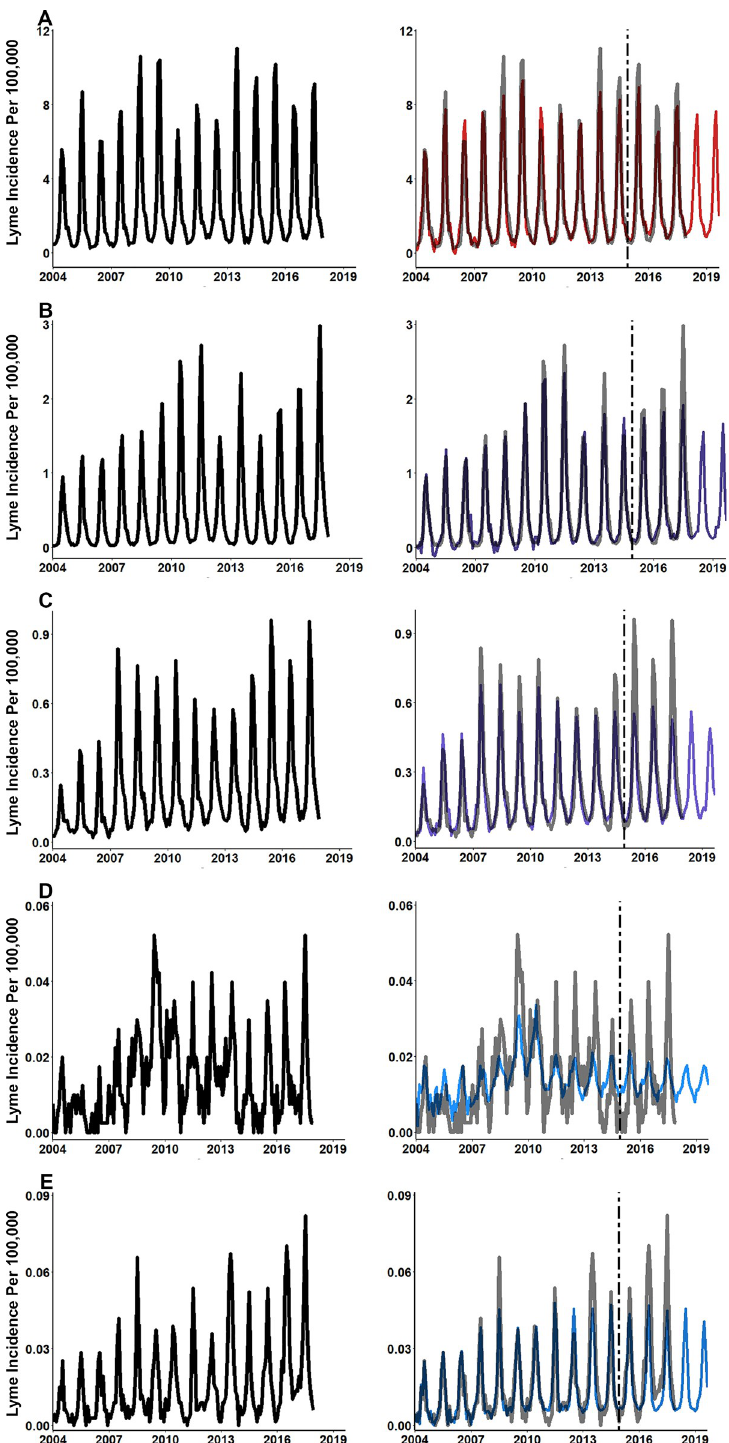
Fig 6. Elastic net modeling using the full-term list produces predictions with greater accuracy and less error. (A) Northeast, (B) Midwest, (C) Southeast, (D) Southwest, and (E) West. Same one-year period from Northeast region with accurate nowcast model. Two elastic net models were developed for each region. Elastic net models trained using CDC surveillance data and search term data from February 2004 through December 2014. Vertical dashed line starts at January 2015 and indicates the start of the hold-out data set. Nowcasting performed using search term data from January 2018 until September 2019. https://doi.org/10.1371/journal.pone.0251165.g006 PLOS ONE | https://doi.org/10.1371/journal.pone.0251165 March 10,